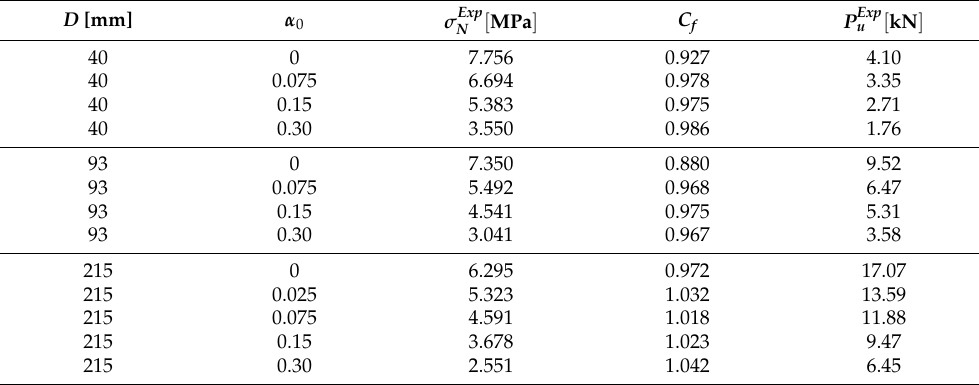
Table 1. Experimental results: nominal strengths σ Exp maximum forces P Exp u (bold number–refer to explanation given in